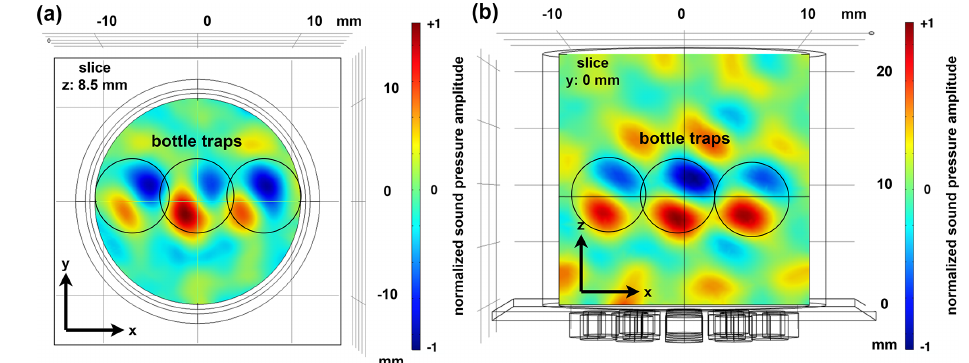
Figure 6. Representation of the sound pressure field (a) in the x – y plane and (b) in the x – z plane in the cavity with simultaneous generation of three bottle traps.